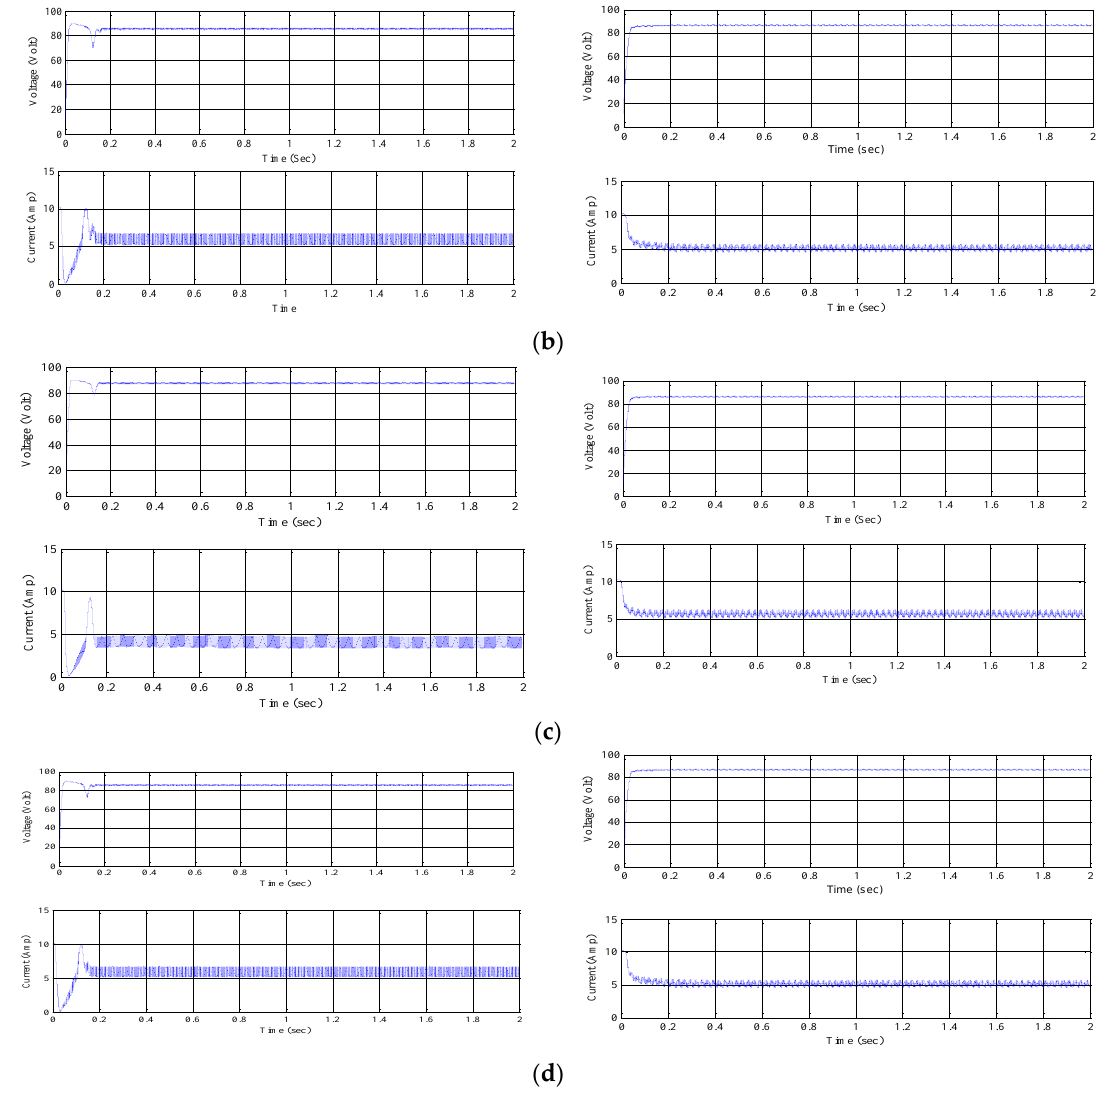
Figure 10. Comparison of output voltage and output current without boost converter obtained using P&O MPPT ( left ) and FLC MPPT ( right ) methods for PV ( a ) panel 1 , ( b ) panel 2 , ( c ) panel 3 and ( d ) panel 4 respectively.